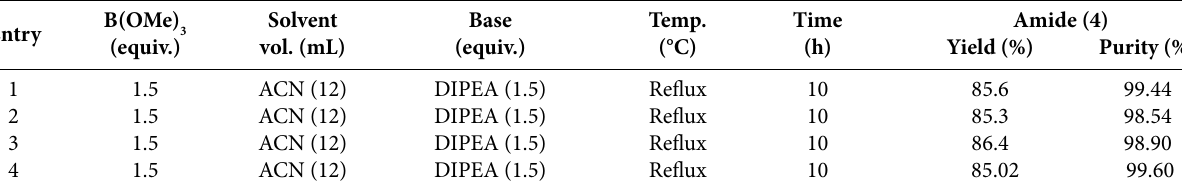
Table 2. Details of yield and purity after optimization for the synthesis of 4 .